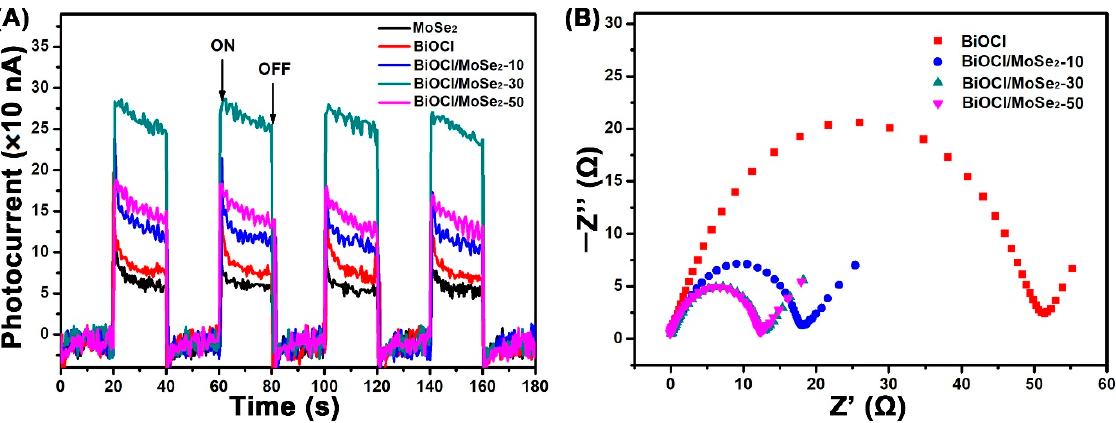
Figure 4. ( A ) Transient photocurrents of MoSe 2 , BiOCl, BiOCl/MoSe 2 -10, BiOCl/MoSe 2 -30, and BiOCl/MoSe 2 -50 under simulated sunlight irradiation; ( B ) Nyquist plots of the electrochemical impedance spectra of BiOCl, BiOCl/MoSe 2 -10, BiOCl/MoSe 2 -30, and BiOCl/MoSe 2 -50.